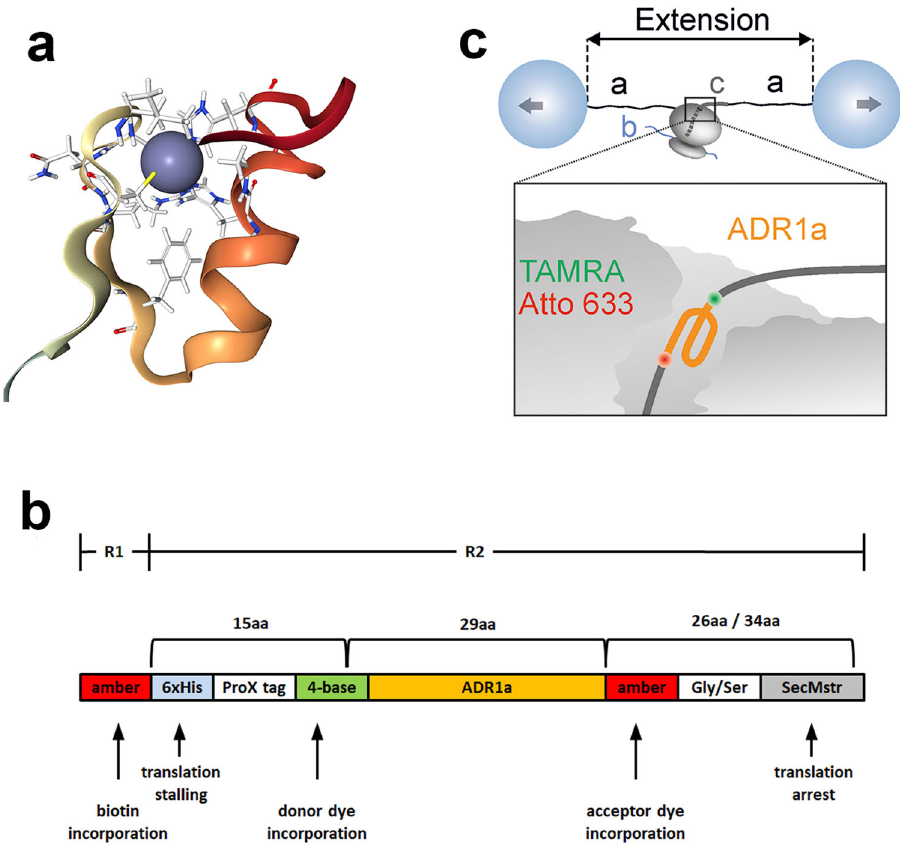
Fig. 1 Experimental setup. a Structure of zinc- fi nger protein domain ADR1a (PDB: 2ADR). The Zn 2 + ion is depicted as a blue sphere. b The construct used in this study. ADR1a was synthesized in a cell-free system in two reaction steps. Transcription/translation reaction 1 (R1) incorporated biotin at the N- terminal amber stop codon with protein synthesis stalled at the His-tag. After addition of histidine, protein synthesis continued and transcription/ translation reaction 2 (R2) incorporated the donor dye TAMRA and the acceptor dye Atto633 at the two termini of ADR1a. The SecMstr arrest peptide ensured that the fully synthesized protein remained bound following translation. c Cartoon of experimental setup at the optical tweezers, where a depict the DNA handles, b the mRNA of the stalled construct, and c the SecMstr-stalled nascent